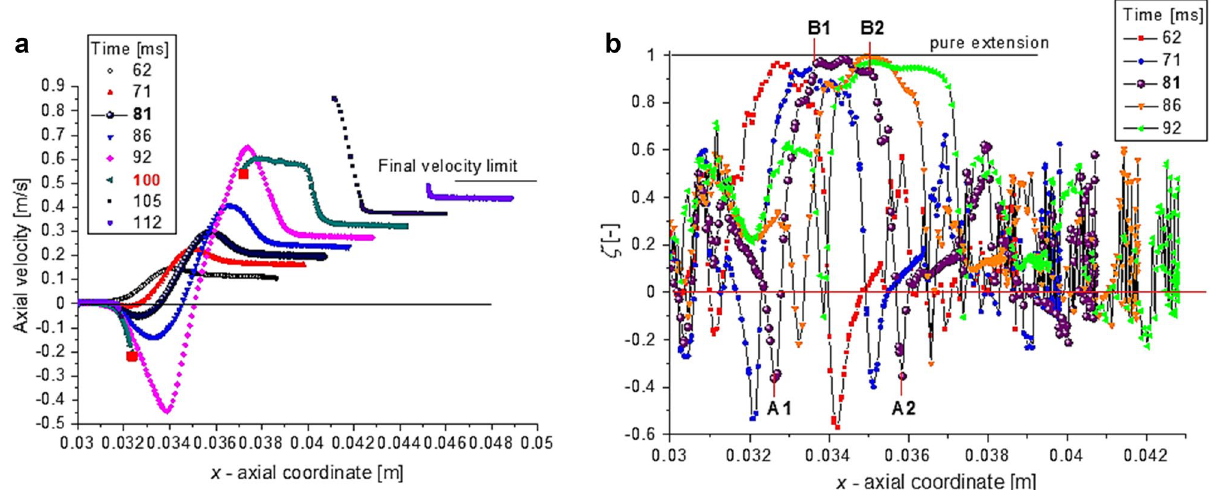
v x and ( b ) ζ -coefficient distributions on the droplet/filament interface at Figure 6. ( a ) Axial velocity v ax = different values of time (at t = 81 ms the curves are bolded).